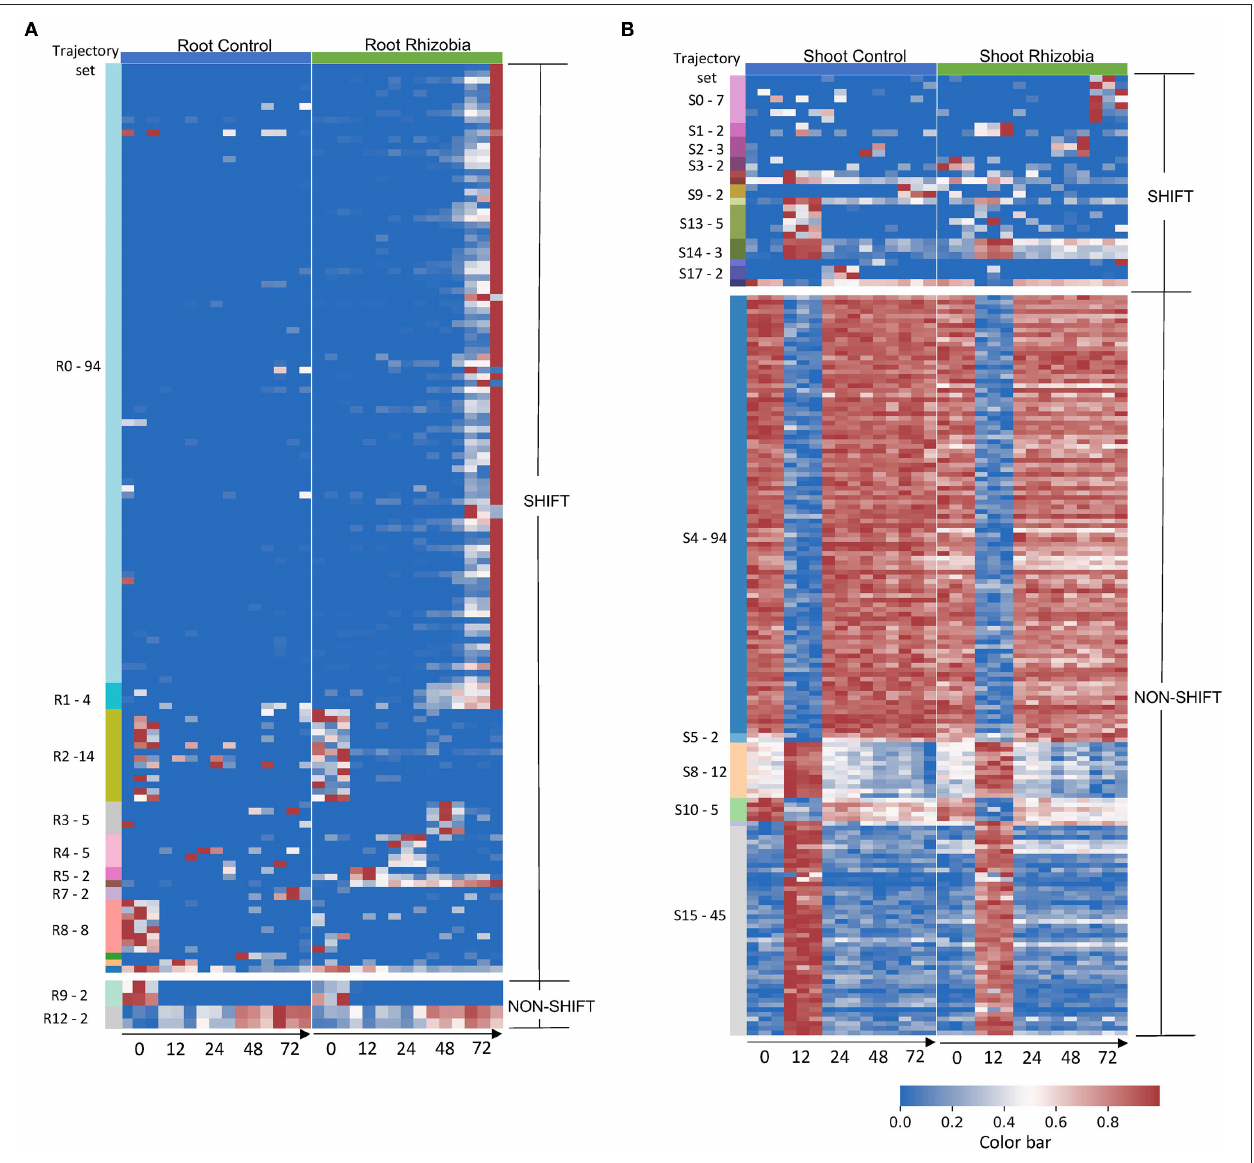
FIGURE 3 | Gene expression profile in root and shoot of control and rhizobia-infected Medicago plants over 72 h. (A) Heatmap of 142 root genes and (B) . Heatmap of 190 shoot genes that GeneShift identified. Data are presented in the heatmap using log2 (x+1) transformed FPKM expression values. Each row represents a gene, and each column represents the expression profile for a single biological sample. The color reference to the left of each heatmap is representing GeneShift trajectory groups (R = root, S = shoot) and the number of genes in that trajectory set. The trajectory sets contain only one gene were not annotated. The numbers below the heatmap represent hours post inoculation (hpi). The color bar represents the relative gene expression in a row.